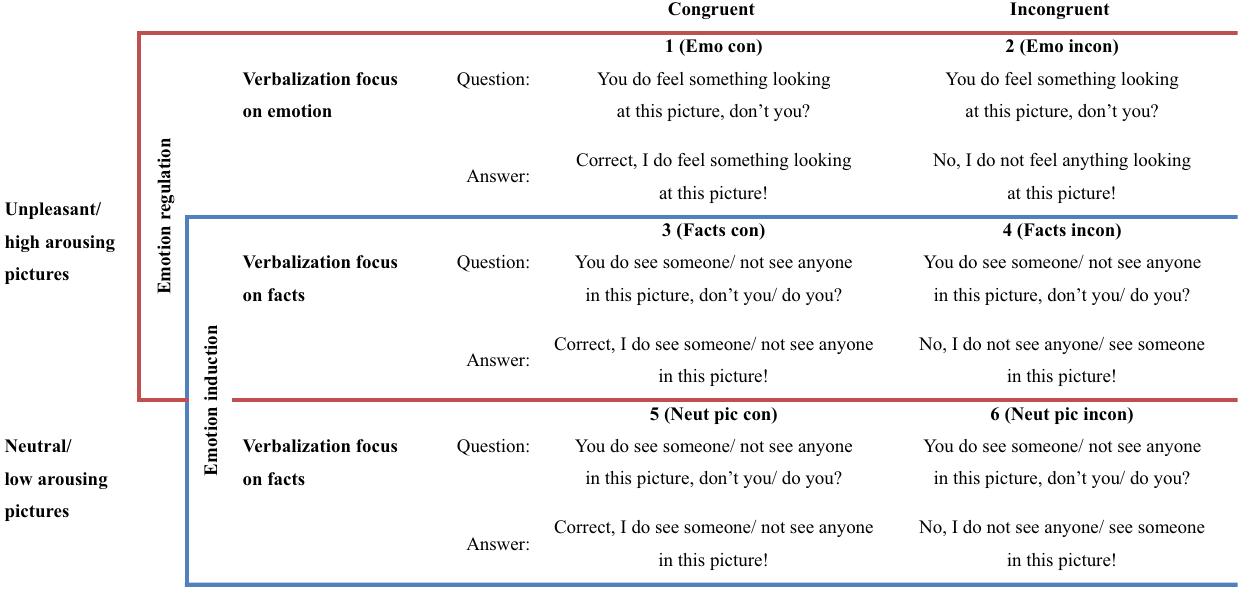
Table 2 | Overview about design and stimulus